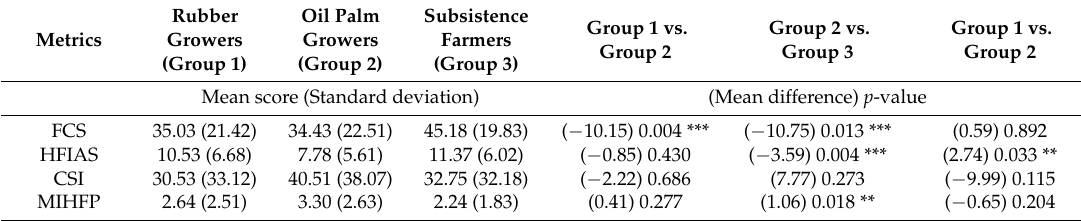
Table 3. Mean food security indicator scores and differences between study groups.